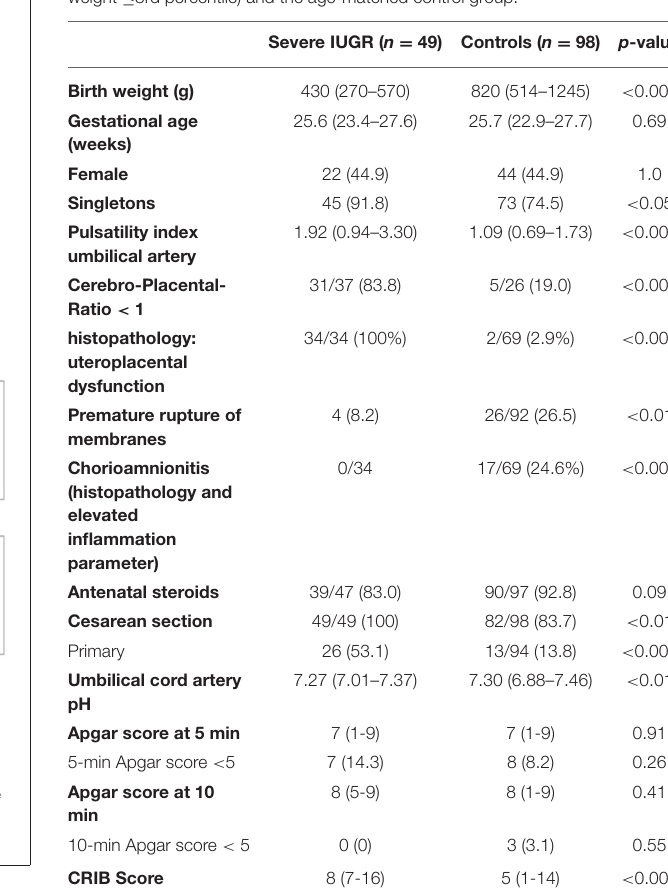
TABLE 1 | Demographic and clinical data of the ELGANs with severe IUGR (birth weight ≤ 3rd percentile) and the age-matched control